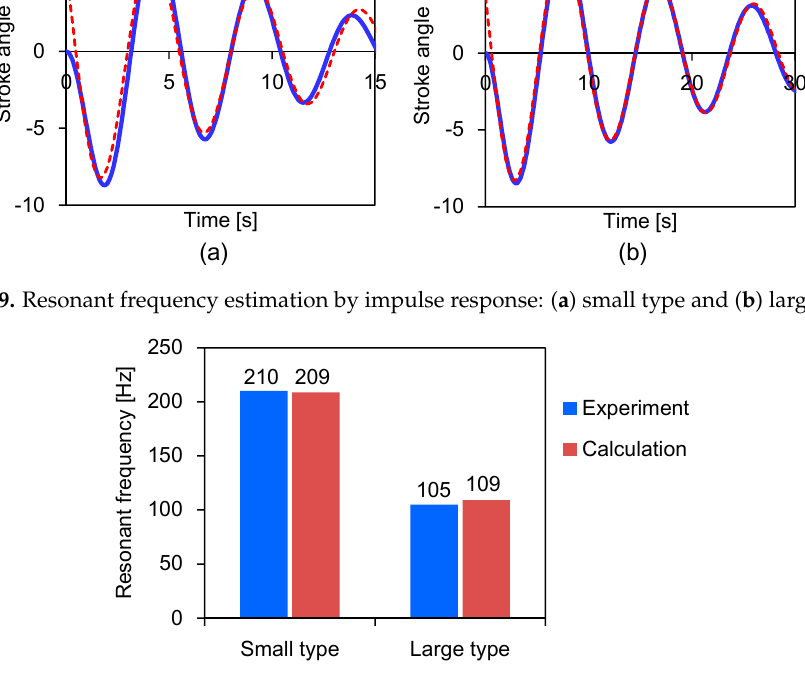
Figure 10. Measured and calculated resonant frequencies.